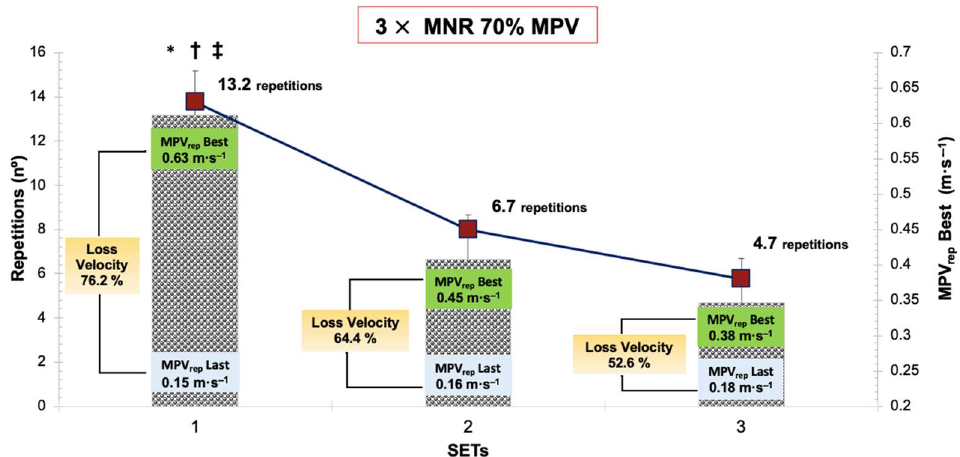
Figure 3. Comparison of the repetitions performed in the three sets, with the MPV of the best repetition and velocity loss percentage between the MPV of the best repetition and the MPV of the last repetition. Rep = repetition; MPV = Mean Propulsive Velocity; MRN = Maximum Number of Repetitions; * Repetitions = significant difference between all sets ( p < 0.05); † MPV rep Best = significant difference between all sets ( p < 0.05); ‡ % loss MPV = significant difference between all sets ( p < 0.05). The obtained data of the MPV at 1 m · s − 1 test before and after the BP exercise protocol show significant differences between all measurements ( F (4,43) = 169.885, p < 0.001, η p2 = 0.798, SP = 1.000), except for the MPV at minute 10 and 15 after the exercise ( p > 0.05) (Figure 4).